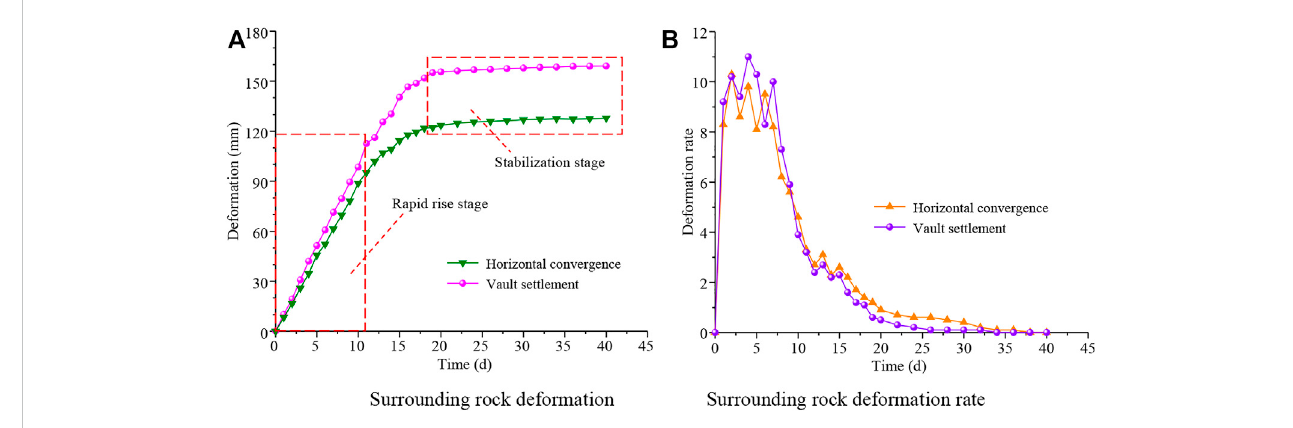
FIGURE 11 Surrounding rock deformation. (A) Surrounding rock deformation (B) Surrounding rock deformation rate.